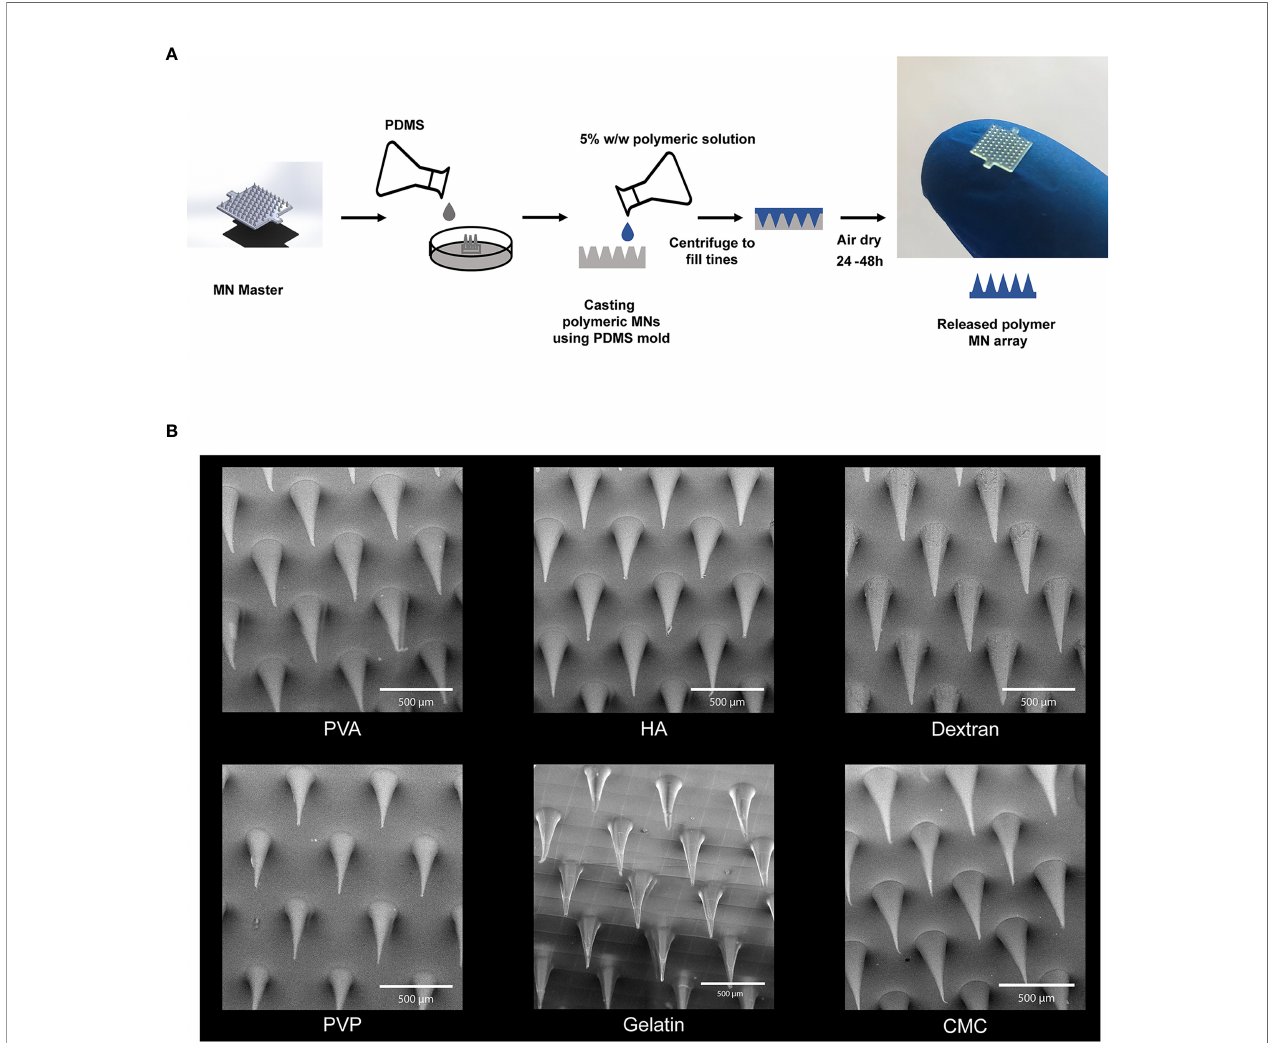
FIGURE 1 | Microneedles were fabricated using six different polymers. (A) Schematic of fabrication scheme for making the MNs. (B) SEM Images of the MNs fabricated using high MW degradable polymers. Scale bar =